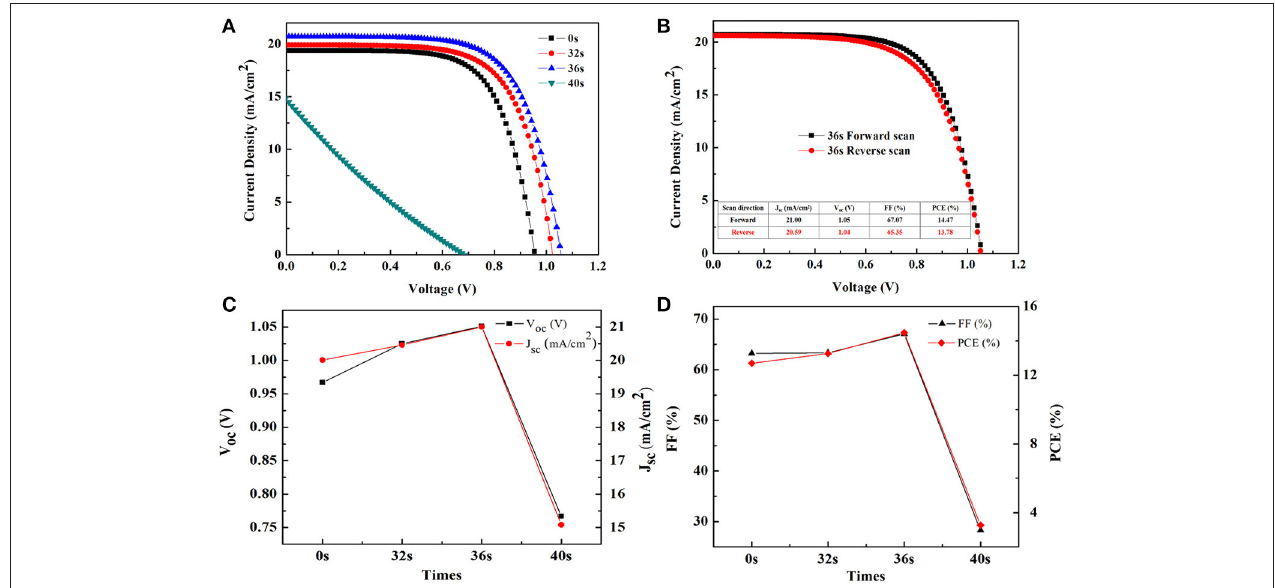
FIGURE 4 | (A) J-V curves under the AM 1.5G simulated sunlight illumination (100 mW/cm 2 ) for the inverted planar perovskite solar cells with different BCP evaporation times; (B) J-V curves of the best performance of the PSCs with BCP evaporation time 36s; Changes of the (C) open-circuit voltage ( V OC ) and short-circuit photocurrent density ( J SC ), (D) fill factor ( FF ) and power conversion efficiency ( PCE ) at different BCP evaporation times.